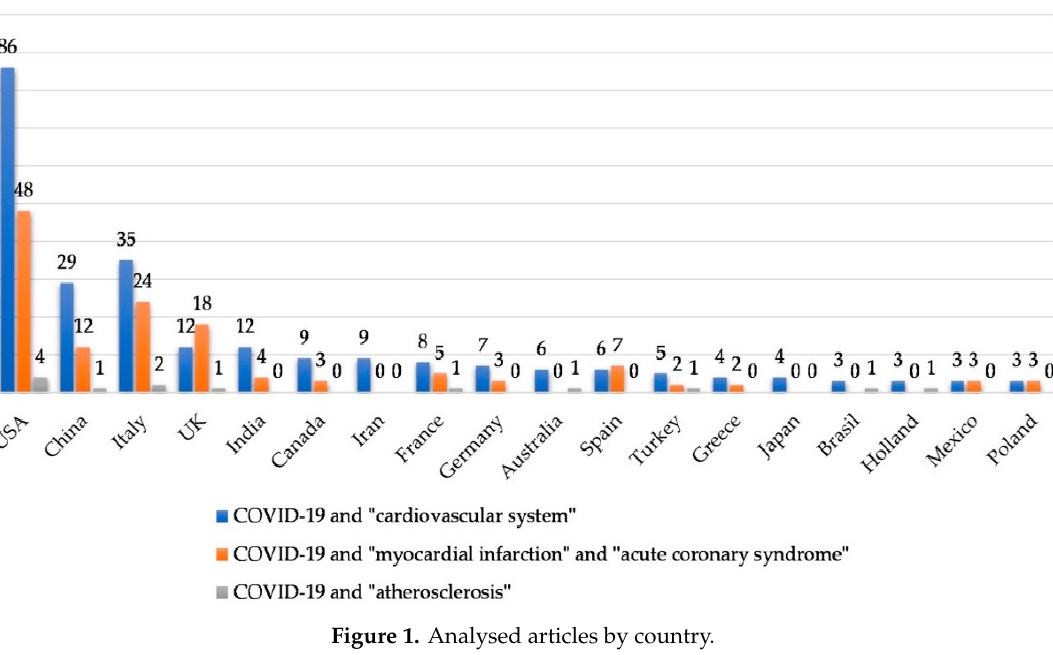
Figure 1. Analysed articles by country.